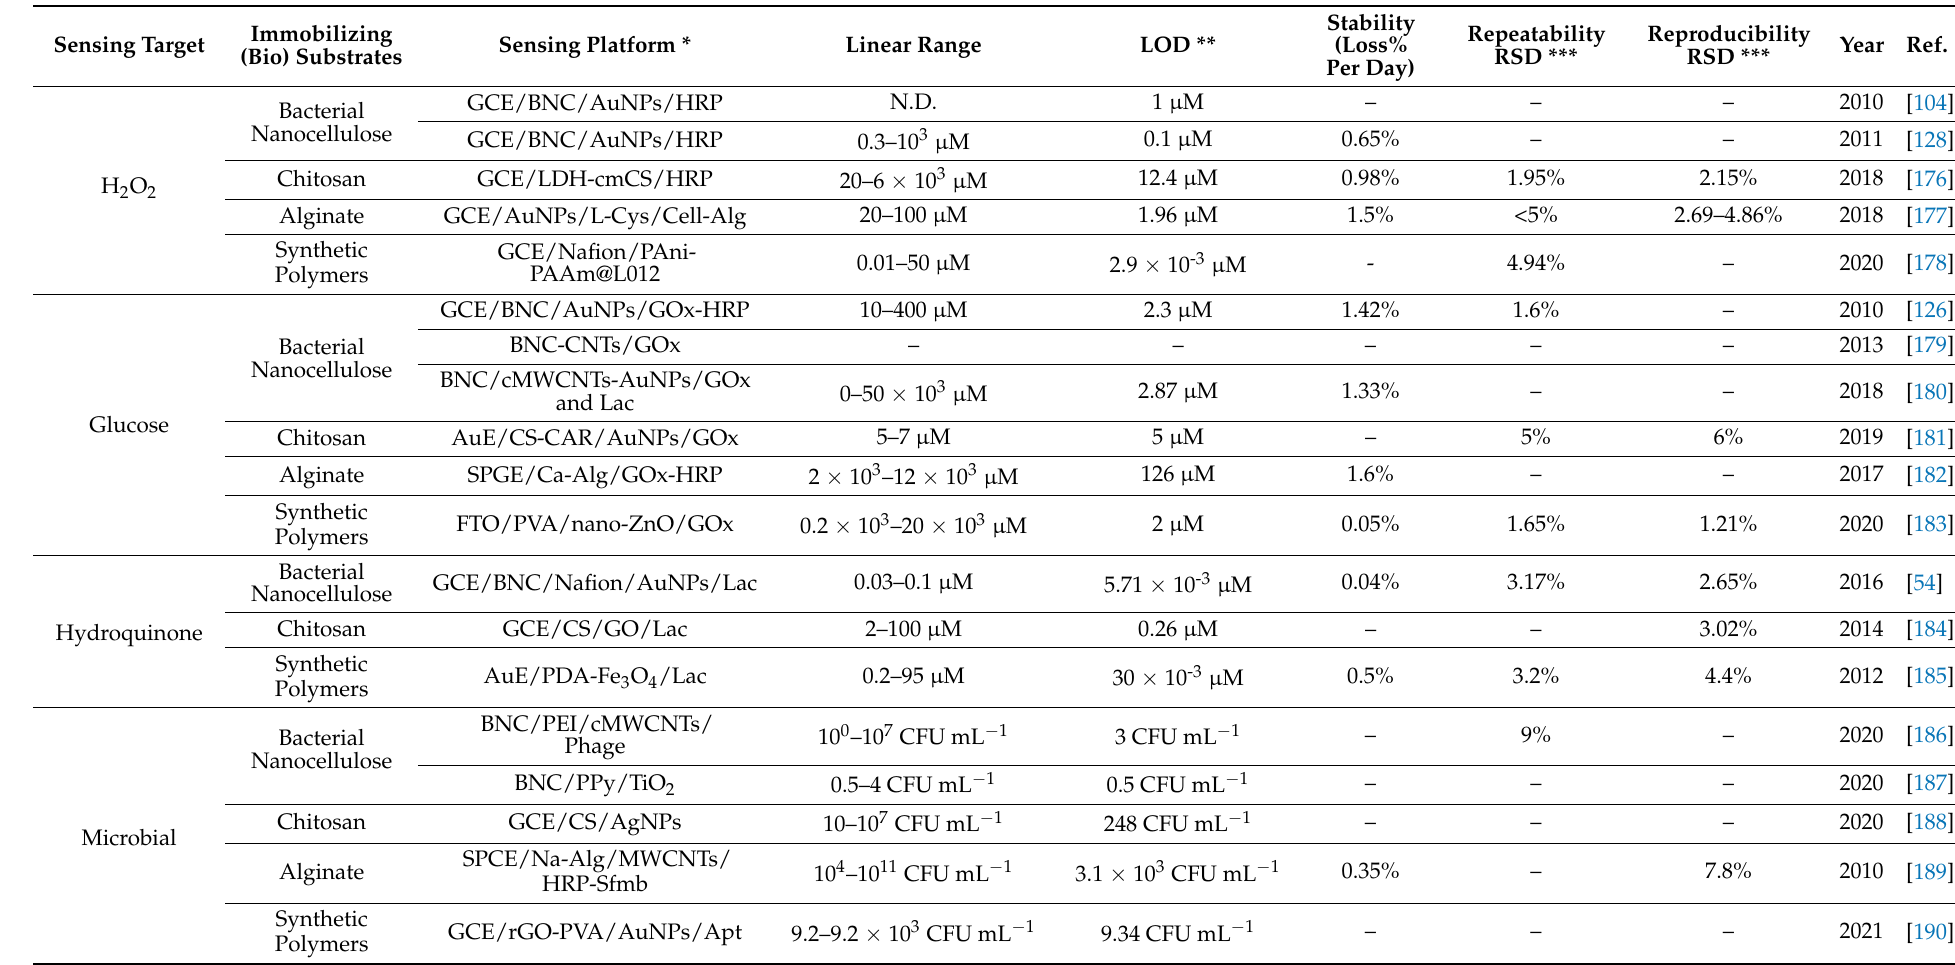
Table 3. Summary comparisons between BNC-based and alternative polymer-based platforms used for biosensing